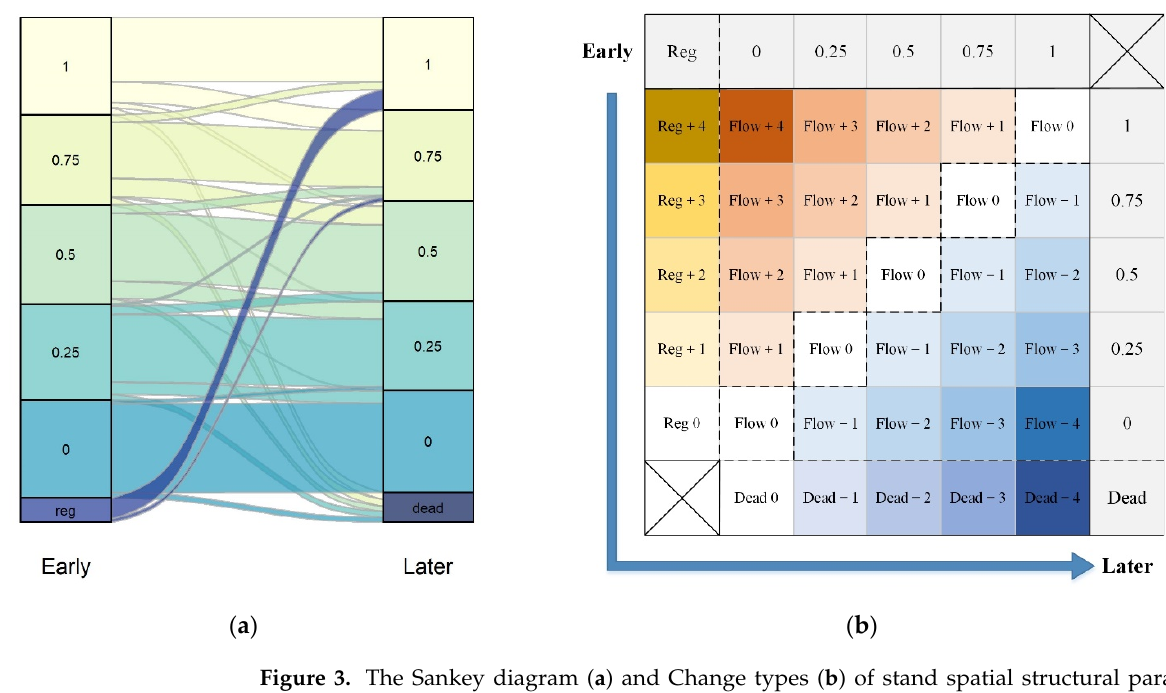
Figure 3. The Sankey diagram ( a ) and Change types ( b ) of stand spatial structural parameters between two periods. The “reg” means the regeneration in early stage and growing into a living tree (DBH ≥ 5 cm) in later stage. The “dead” means the living trees in early stage, that have died in later stage. The flows in ( a ) connect the structural attributes of trees between the early and later periods. Each flow represents a change type shown in ( b ), and the width of the flow represents the relative proportion of this change type. The dotted lines in ( b ) divide 35 change types into recruitment process, ascending flow, stable flow, descending flow and mortality process with the colors of gold, orange, white, light blue and dark blue, respectively. The darker the color, the greater the change range of structure attributes. These change types in the ascending flow, stable flow and descending flow change can be further combined into nine change types according to the change range (the depth of color, see Section 2.3.1 for more details).